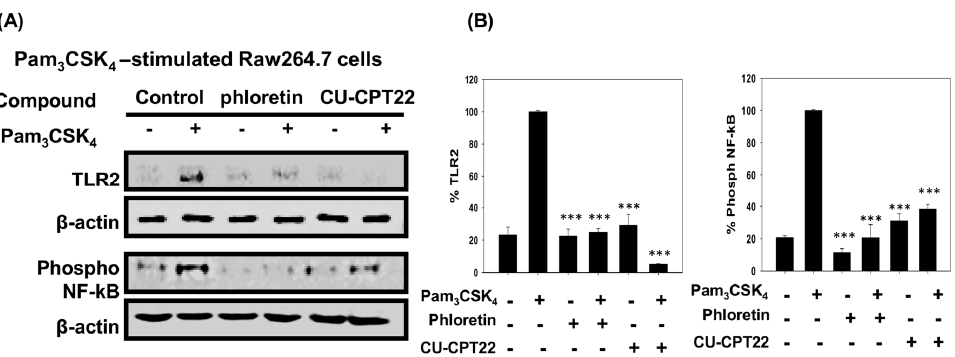
Figure 4. Quantification of protein expression using Western blotting. ( A ) Indicated protein levels